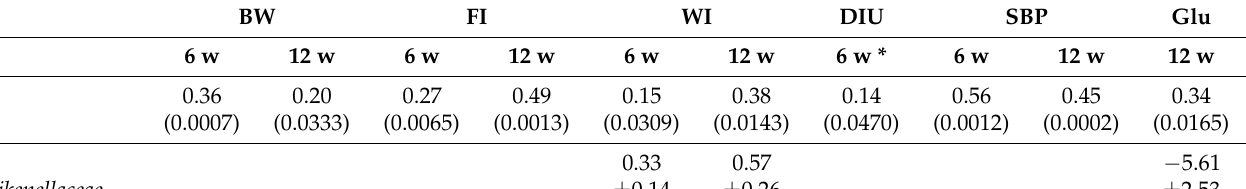
Table 1. Regression fits for each of the physiological variables studied using as independent variables those families that show statistical differences in the percentage of sequences retrieved from fecal samples at six weeks. BW, body weight; FI, food intake, WI, water intake; DIU, diuresis; SBP, systolic blood pressure; Glu, glucose. BW